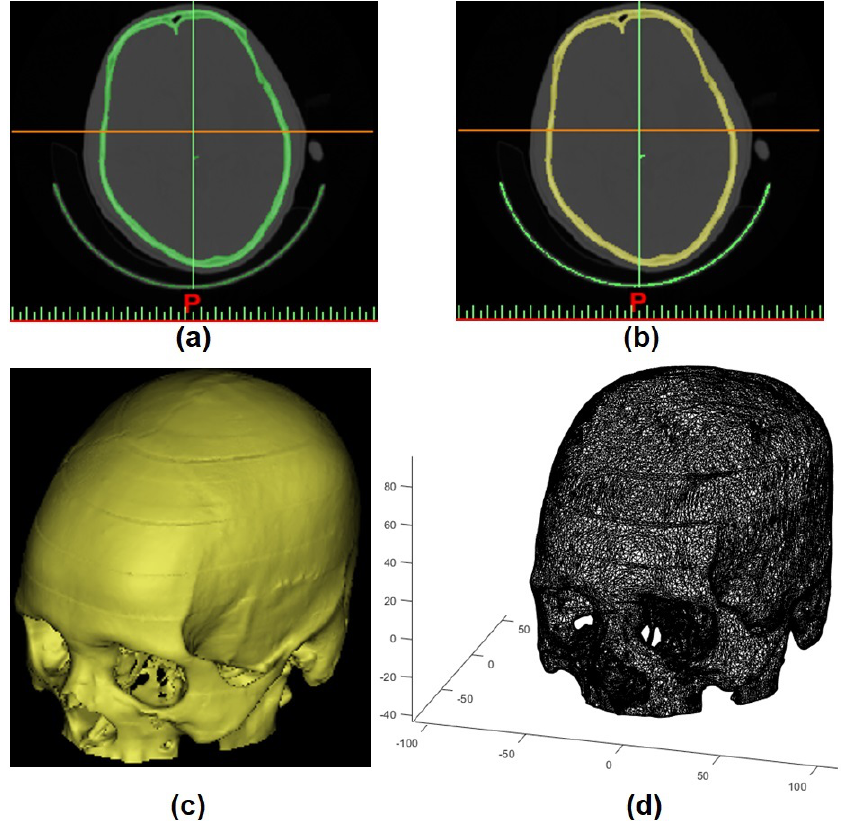
Figure 2. ( a ) thresholding applied in CT scan, ( b ) region growing, ( c ) 3D mesh model (STL model), and ( d ) STL model converted into